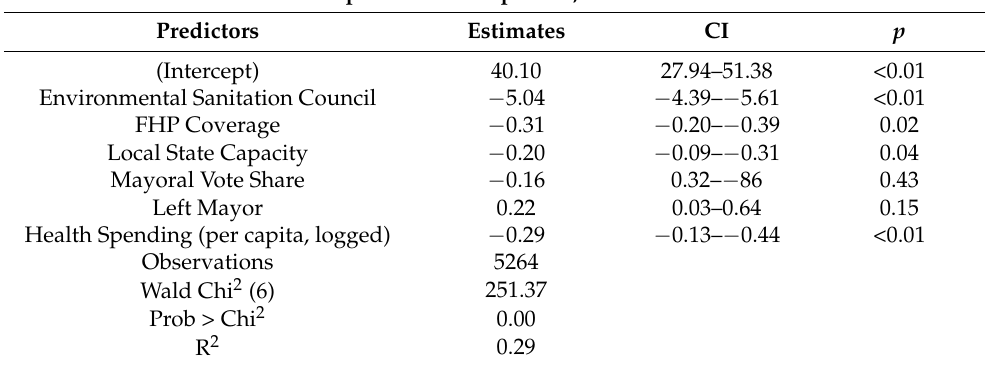
Table 2. This table reports the results of OLS estimation following pre-processing through Coarsened Exact Matching.